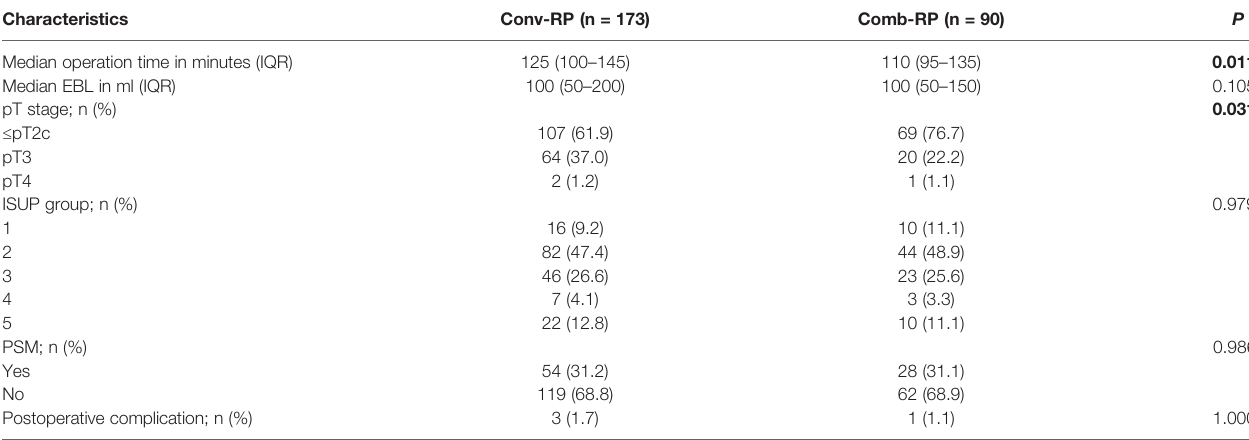
TABLE 2 | Perioperative and pathological parameters of patients undergoing Conv-RP or Comb-RP.